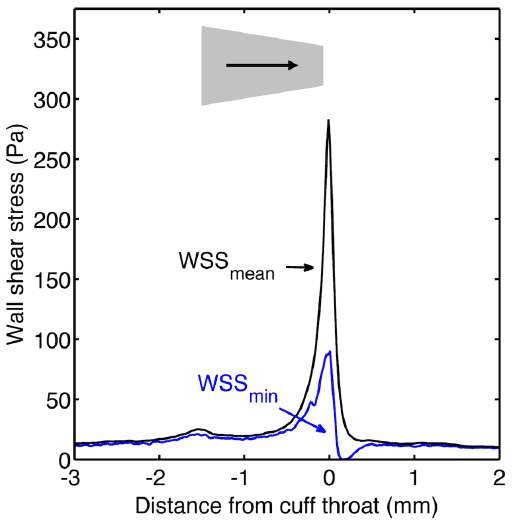
Fig. 6. Mean and minimum WSS along vessels with the cuff in the conventional orientation. Plot of circumferential minimum and circumferential mean WSS versus distance along the vessel for the mouse with the cuff in the forward direction. Flow direction, cuff location and cuff orientation are indicated as described for Fig